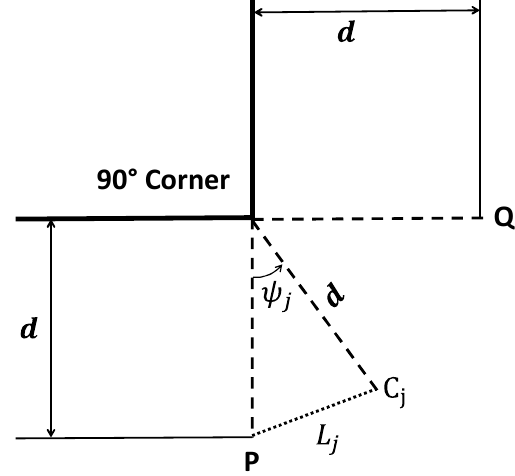
Table 1. Camera positions ( ψ ) for 90° and 55° corner sites Corresponding to above camera positions for a corner, four images are numbered as 1, 2, 3, and 4. In order to mark the camera positions on ground, two perpendiculars are drawn to both the facades of the walls for making the circular path. On these normal lines, reference points P and Q are marked on ground at shooting distance ( d ) from the building corner. Figure 7 shows the schematic view of the field procedure for marking a camera position for the 90° corner.